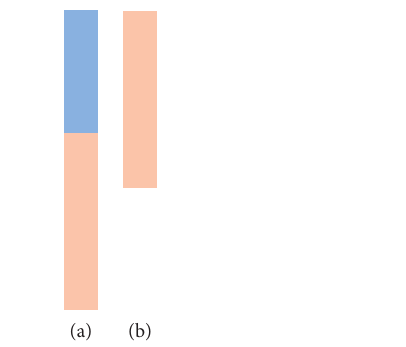
Figure 6: Oil level and pretreatment results of the transformer. (a) Power transformer oil pipe diagram. (b) Oil level pretreatment